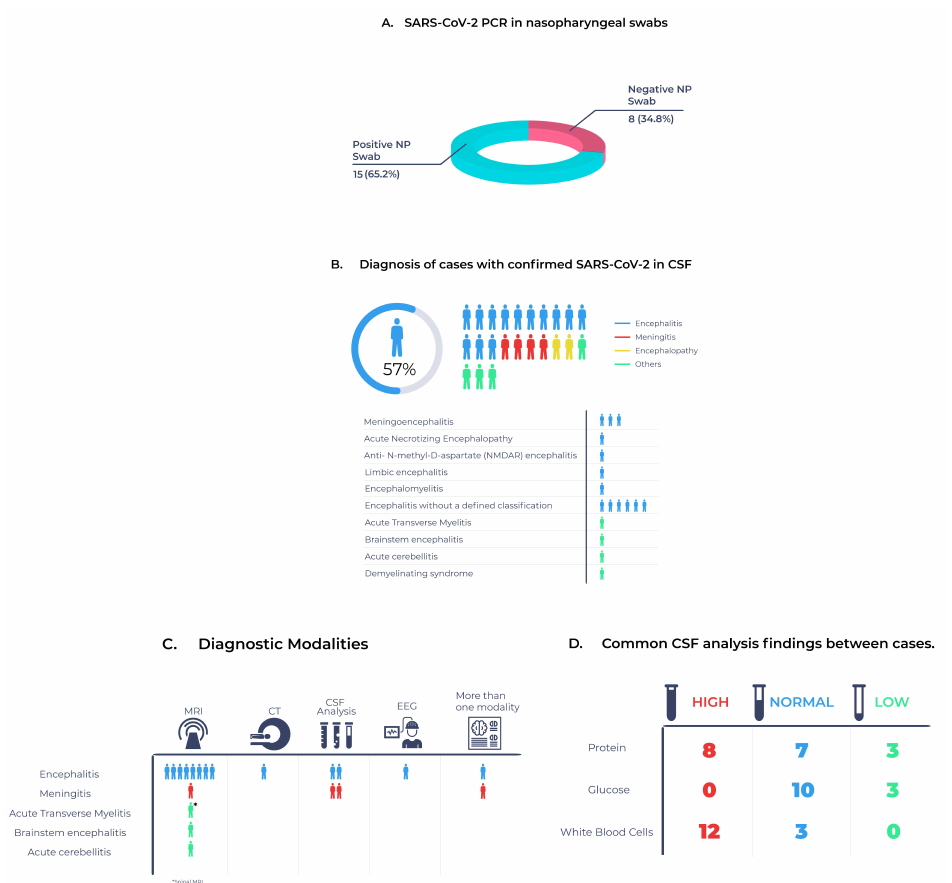
Figure 2. Visual summary of the significant findings in ( A ) results of SARS-CoV2 PCR in nasopha- ryngeal swabs, ( B ) diagnosis reached for cases with confirmed SARS-CoV-2 in CSF, ( C ) modalities for confirming the diagnosis, and ( D ) common CSF analysis findings between